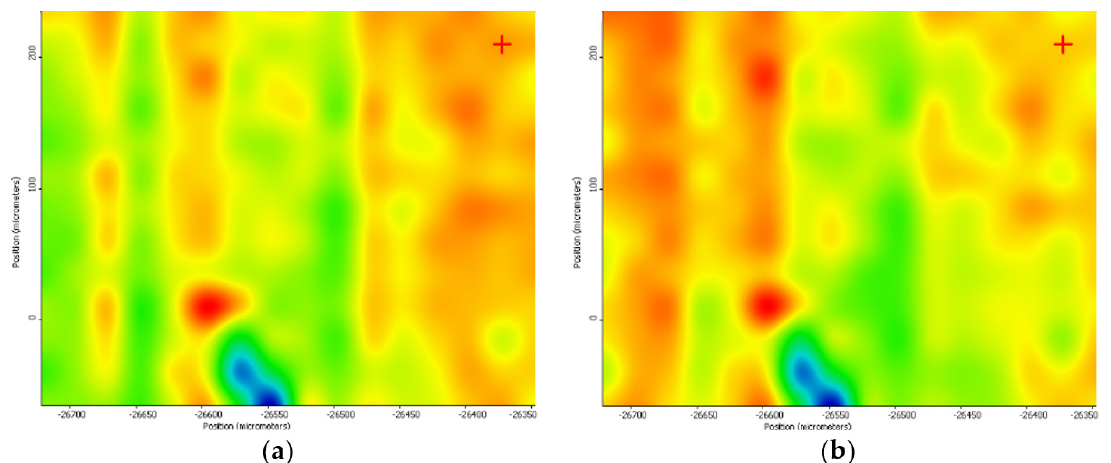
Figure 11. IR maps of PVP/ZnO@LiN based on the distribution of C–H ( a ) and C=O ( b ) bonds at 200 mJ/cm 2 laser fluence. Significant deposition enhancement is observed at a 300 mJ/cm 2 laser fluence (Figure 12). In this case, the coatings are homogeneously deposited, there are no agglomerations or areas in which the sample material lacks.